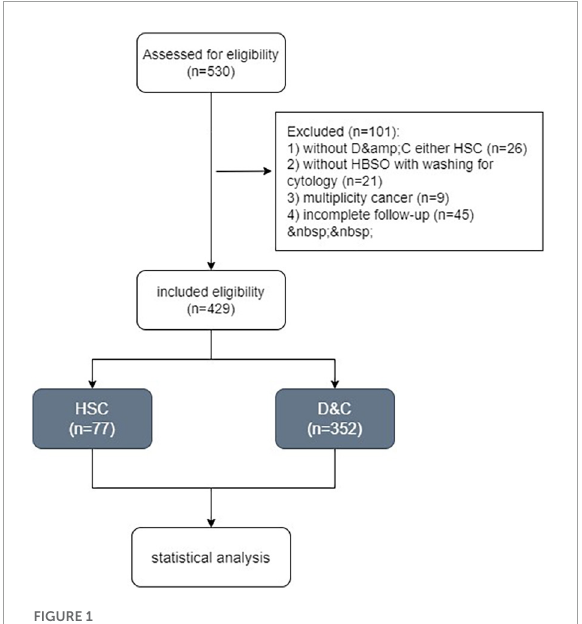
FIGURE1 Patients collection